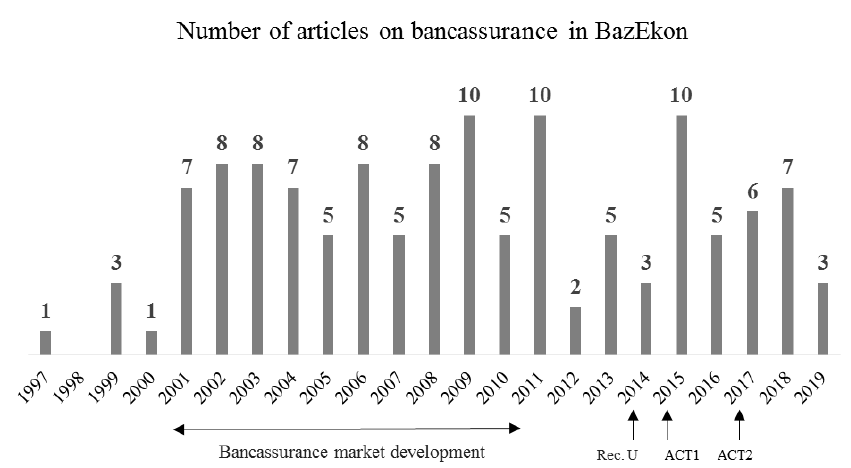
Figure 1. Number of publications in the EKON database with bancassurance as a keyword in the years 1997–2019, source: own study based on data from EKON.